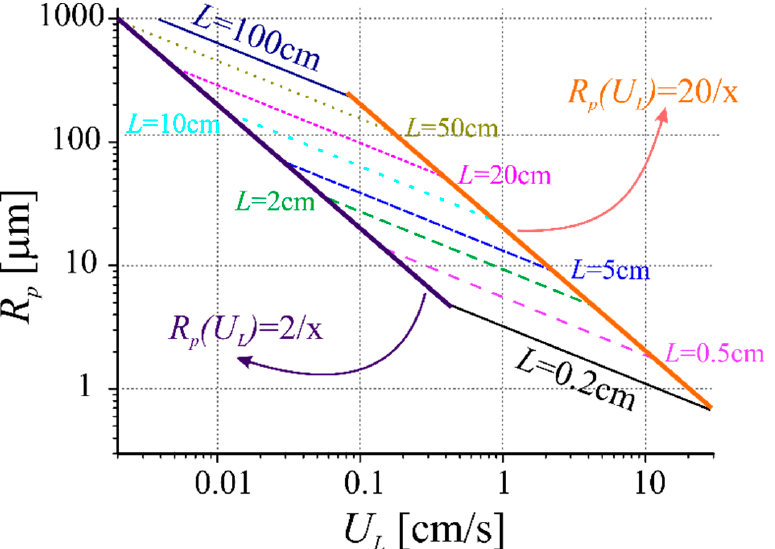
Figure 7. The interrelations between the dimensions of neutrally buoyant particles R p against the flow velocity U L for various length values of the plate L.